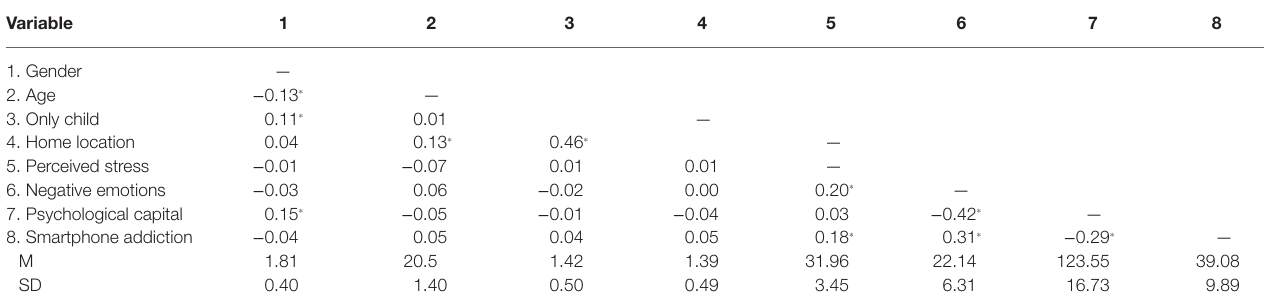
TABLE 1 | Means, standard deviations, and correlations of the main study variables.